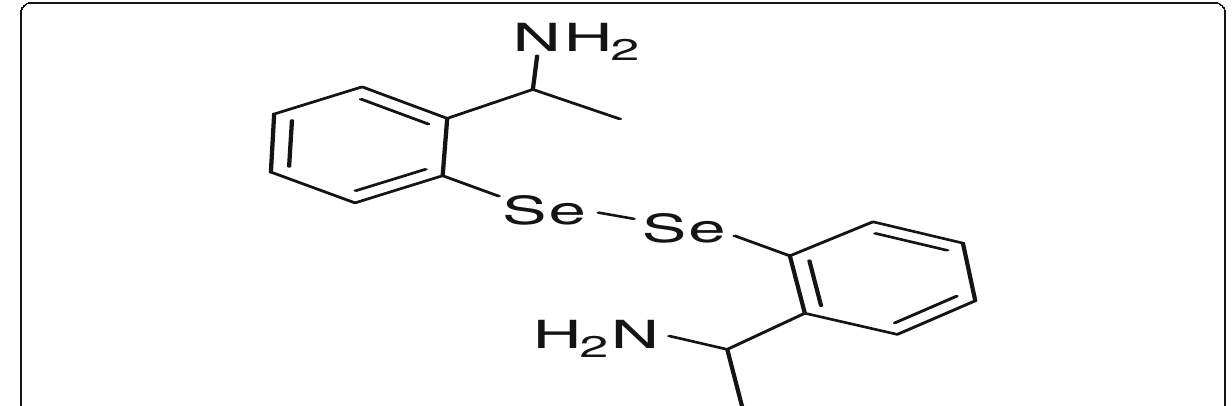
Fig. 1 1-(2-(2-(2-(1-aminoethyl)phenyl)diselanyl)phenyl)ethanamine (APDP) chemical